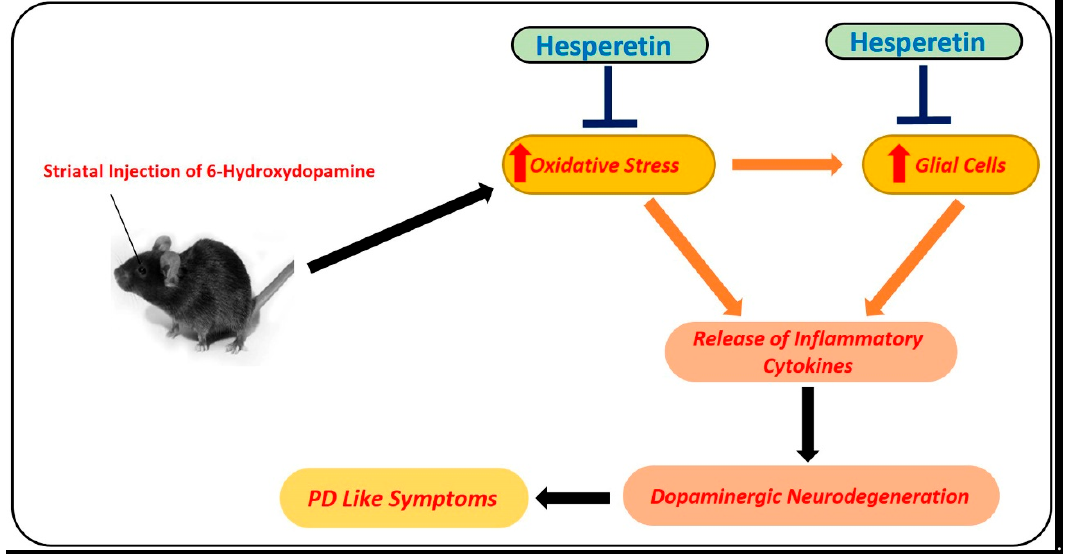
Figure 5. Role of hesperetin in the management of PD-like changes in the mice brains. A simple diagram showing the effects of 6-hydroxydopamine, a potent and known environmental neurotoxin that is used for modeling of PD-like symptoms in mice. Unilateral injection of 6-hydroxydopamine into the striatum of the mice induced oxidative stress, neuroinflammation, and motor dysfunction in mice. These effects were markedly reduced with the administration of hesperetin.